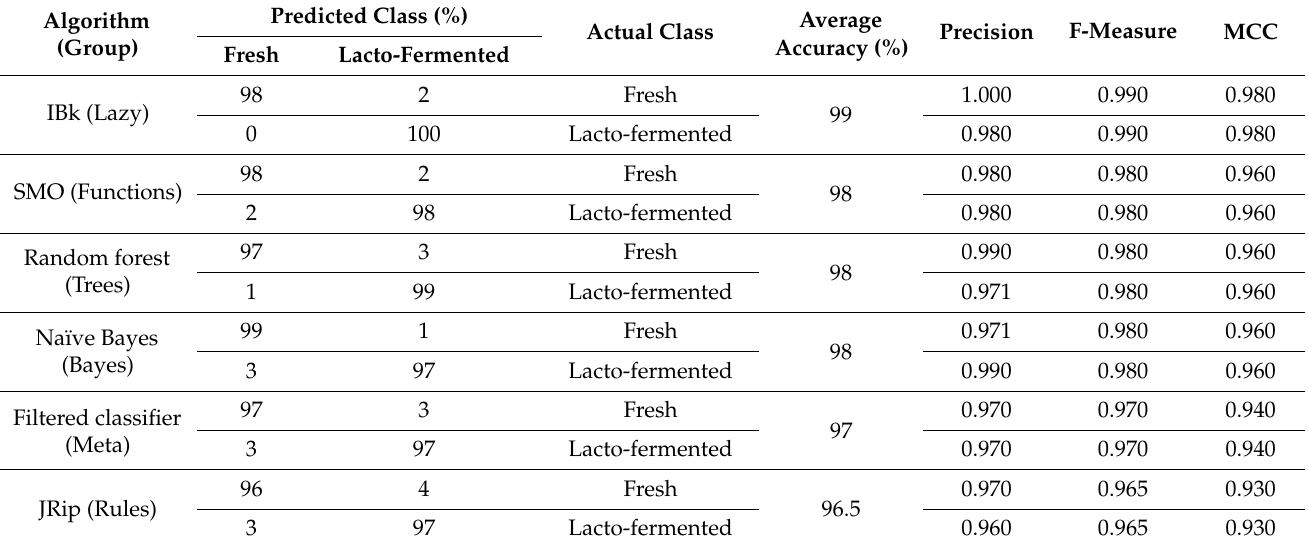
Table 2. The performance metrics of discrimination of fresh and lacto-fermented red bell pepper samples using selected image textures from color space